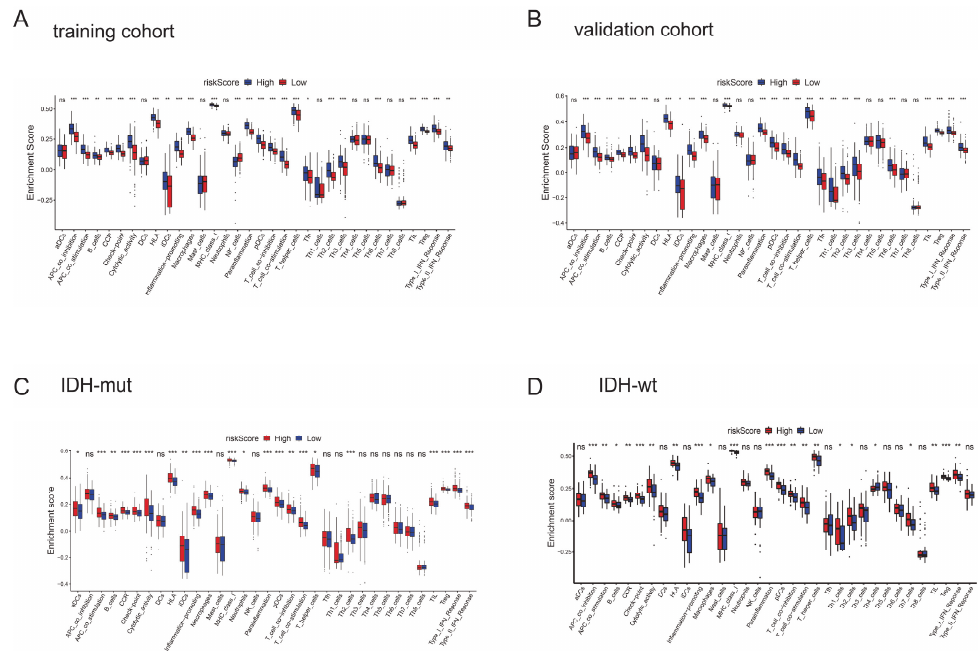
Figure 6. ssGSEA analysis of immune cells and immune pathways. ( A ) Comparison of the enrichment 1 scores of immune cells and immune pathways between different risk groups in the training cohort. ( B ) Comparison of the immune cells and immune pathways in the validation cohort. ( C ) Comparison of the enrichment scores of immune cells and immune pathways between different risk groups in the IDH-mut cohort. ( D ) Comparison of the immune cells and immune pathways in the IDH-wt cohort. p values were shown as: ns not significant; * p < 0.05; ** p < 0.01; *** p < 0.001.